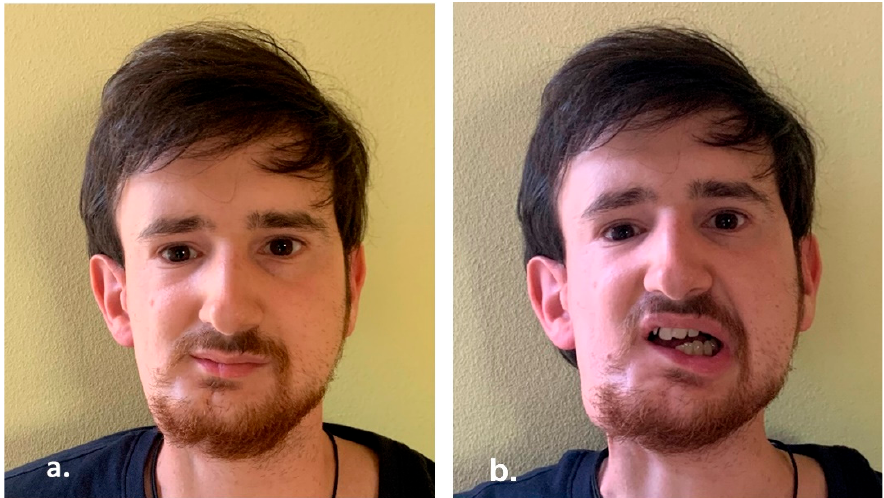
from disease at 15 years follow up (Figure 9).